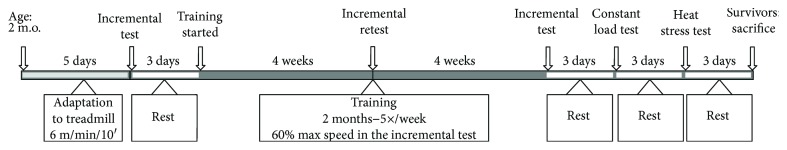
Schematic view of the experimental protocol. Two months old CASQ1-null male mice were randomly selected to perform 2 months of aerobic training. Control WT and untrained (control) CASQ1-null mice were always subjected to identical procedures, without the aerobic training. m.o.: months old.